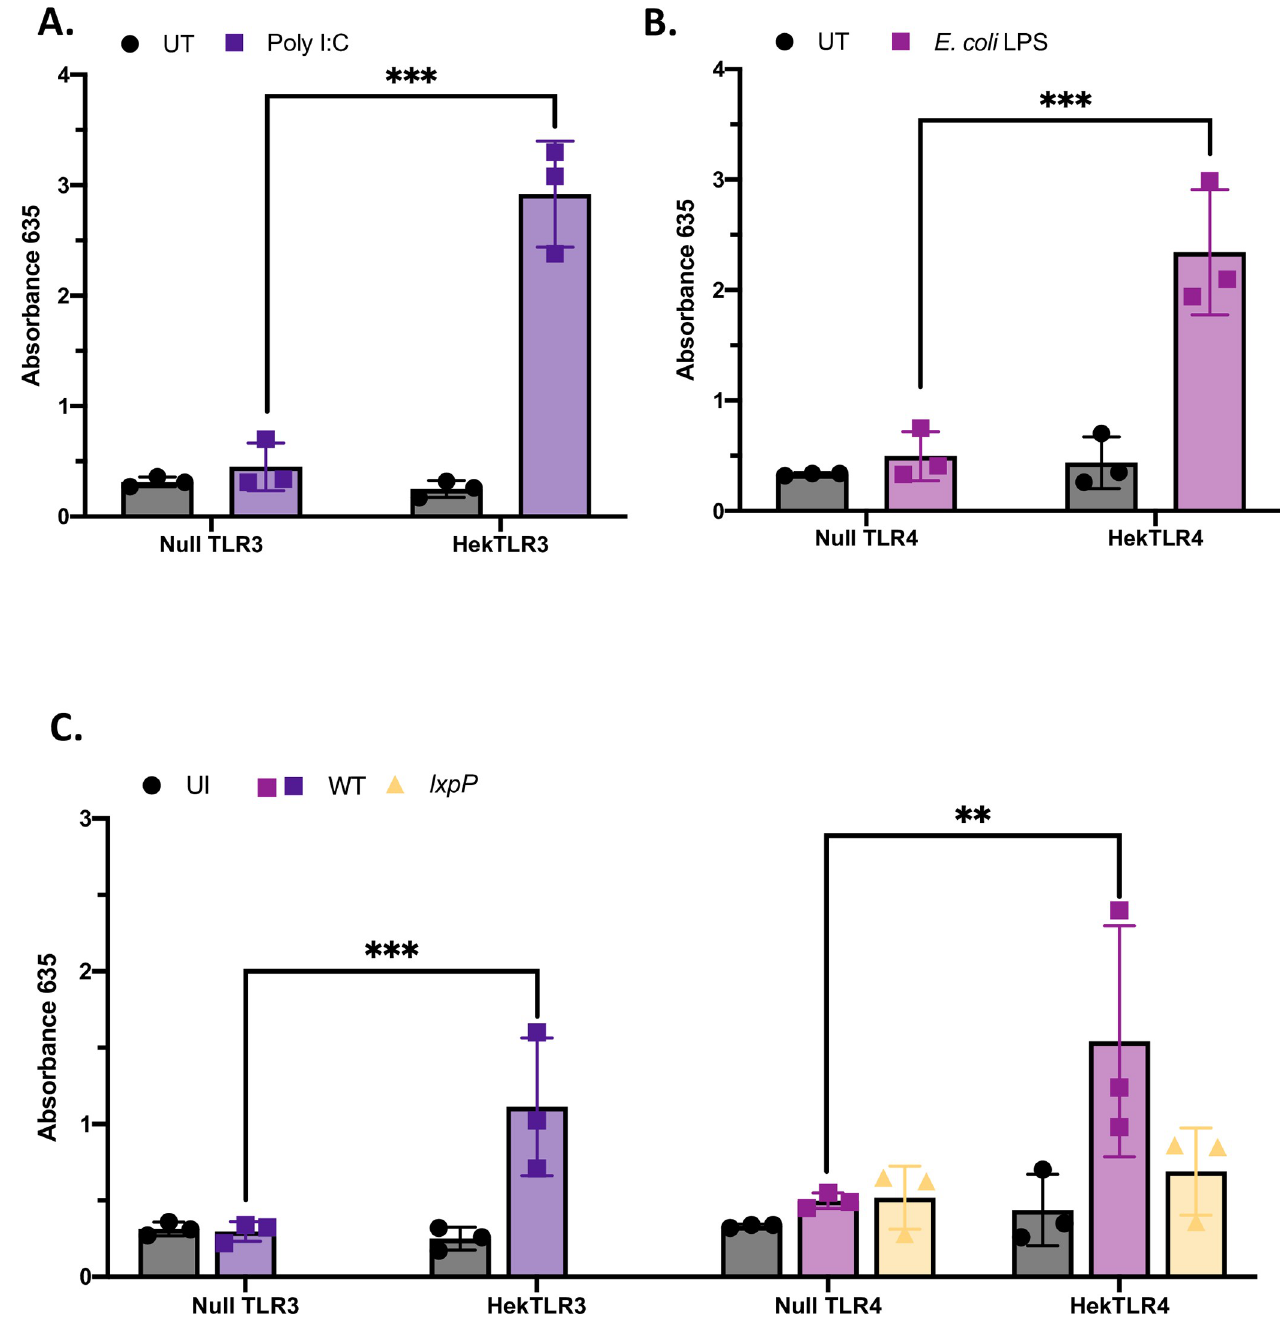
Fig 4. Effect of transfecting TLR3 and TLR4 on the ability of HEK293 cells to respond to L . pneumophila infection. (A-B) Hek-Blue cells expressing TLR3 (TLR3), Hek-Blue cells expressing TLR4 cells (TLR4), and their corresponding control cell lines not expressing the TLR (Null TLR3, Null TLR4) were treated with either vehicle control (UT), Poly I:C (A) or E . coli LPS (B) for 9 h and then the expression of an NF-kB-regulated promotor that is controlled by the levels of TLR activation was monitored via a fused alkaline phosphatase reporter gene. The enzyme produced by the reporter hydrolyzes a colorogenic substrate in the tissue culture medium, and therefore, the activation of the TLR is determined by changes in absorbance. (C) The various Hek-Blue cells were infected with L . pneumophila (Lpn) wildtype (WT) strain 130b or a lpxP mutant derivative ( lxpP ) at a MOI of 50 and assayed after 9 h for activation of TLR3 or TLR4, compared to uninfected control (UI), as described above. Results are presented as absolute absorbance read at 635. Values given are the average ( n = 3 ) pooled from three independent experiments, done in technical triplicate, with standard errors. Asterisks indicate points at which the values for samples from TLR- transfected cells were significantly different from those for samples from null cells ( � P < 0.05, �� P < 0.01, ��� P < 0.001, Student’s t test).